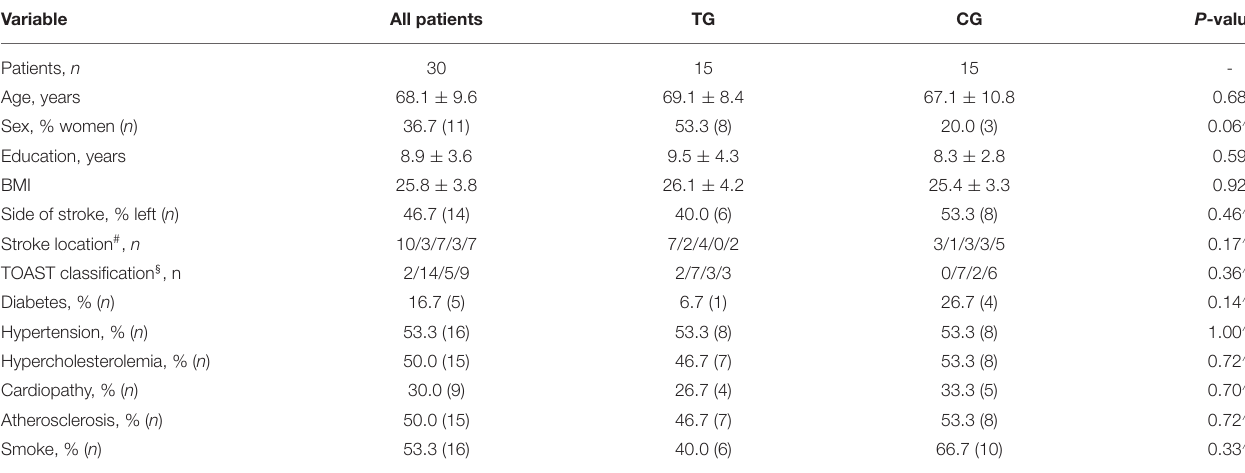
TABLE 1 | Demographic and clinical characteristics of included patients. Variable All patients